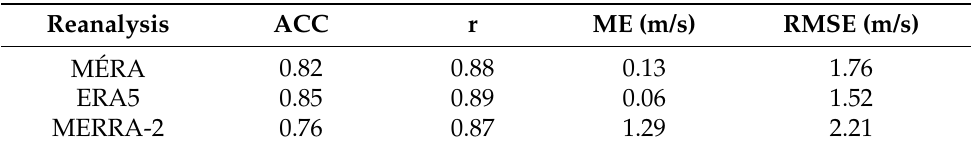
Table 3. Skill scores of each reanalysis compared to observations: anomaly correlation coefficient (ACC), Spearman’s correlation (r), mean error (ME), and root mean square error (RMSE) for hourly 10 m wind speed averaged over all